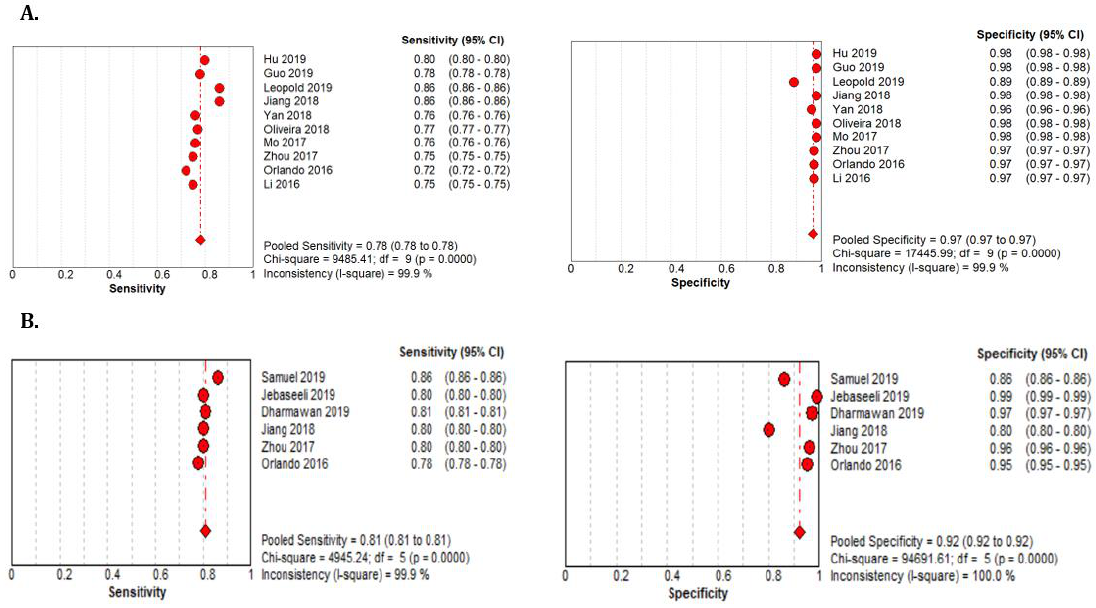
Figure 10. Performance of the DL model retinal vessel segmentation ( A ) pooled sensitivity and specificity of CHASEDB1 dataset ( B ) pooled sensitivity and specificity of the HRF dataset. Table 3. Summary Estimates of DL performance in retinal vessel segmentation.